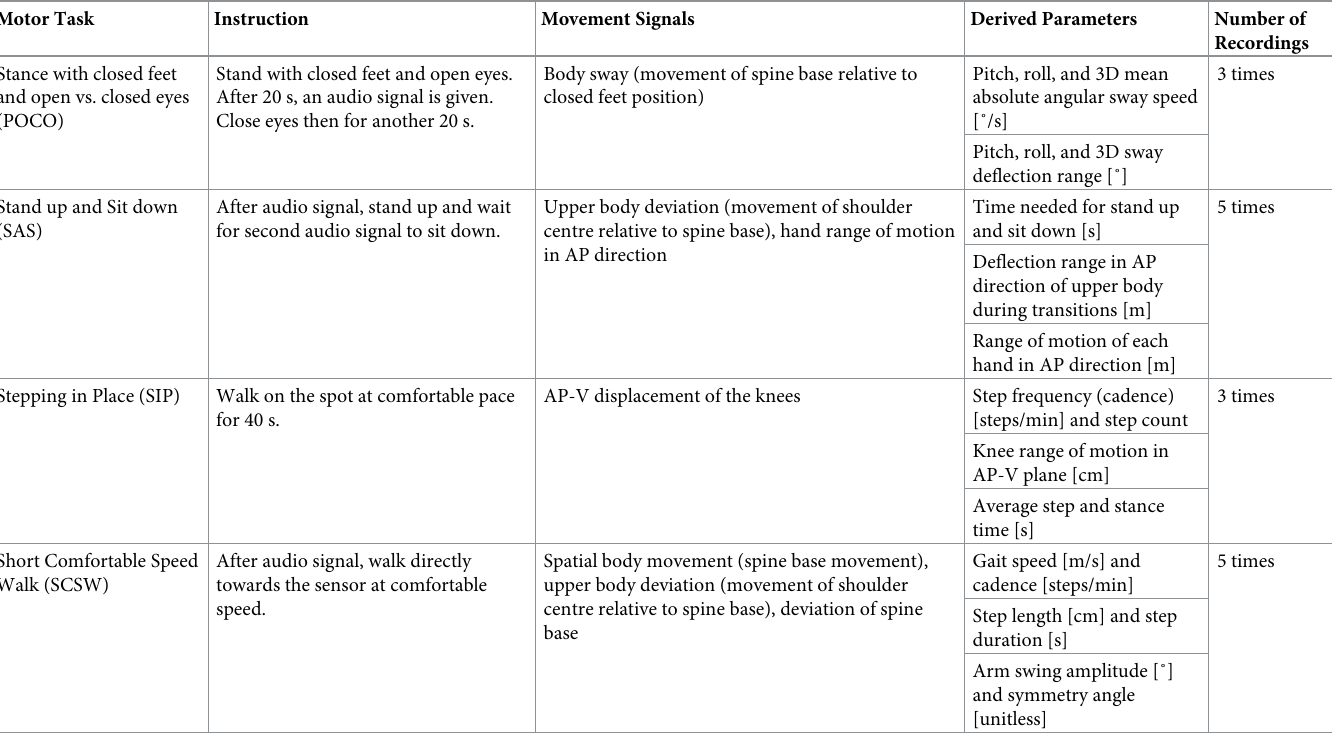
Table 2. Overview of performed motor